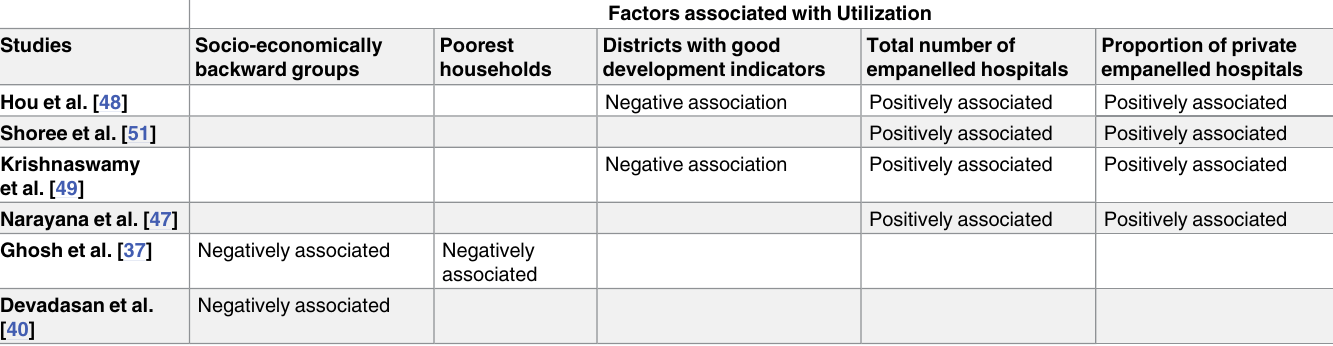
Table 6. Factors associated with utilization in publicly financed insurance schemesin India.